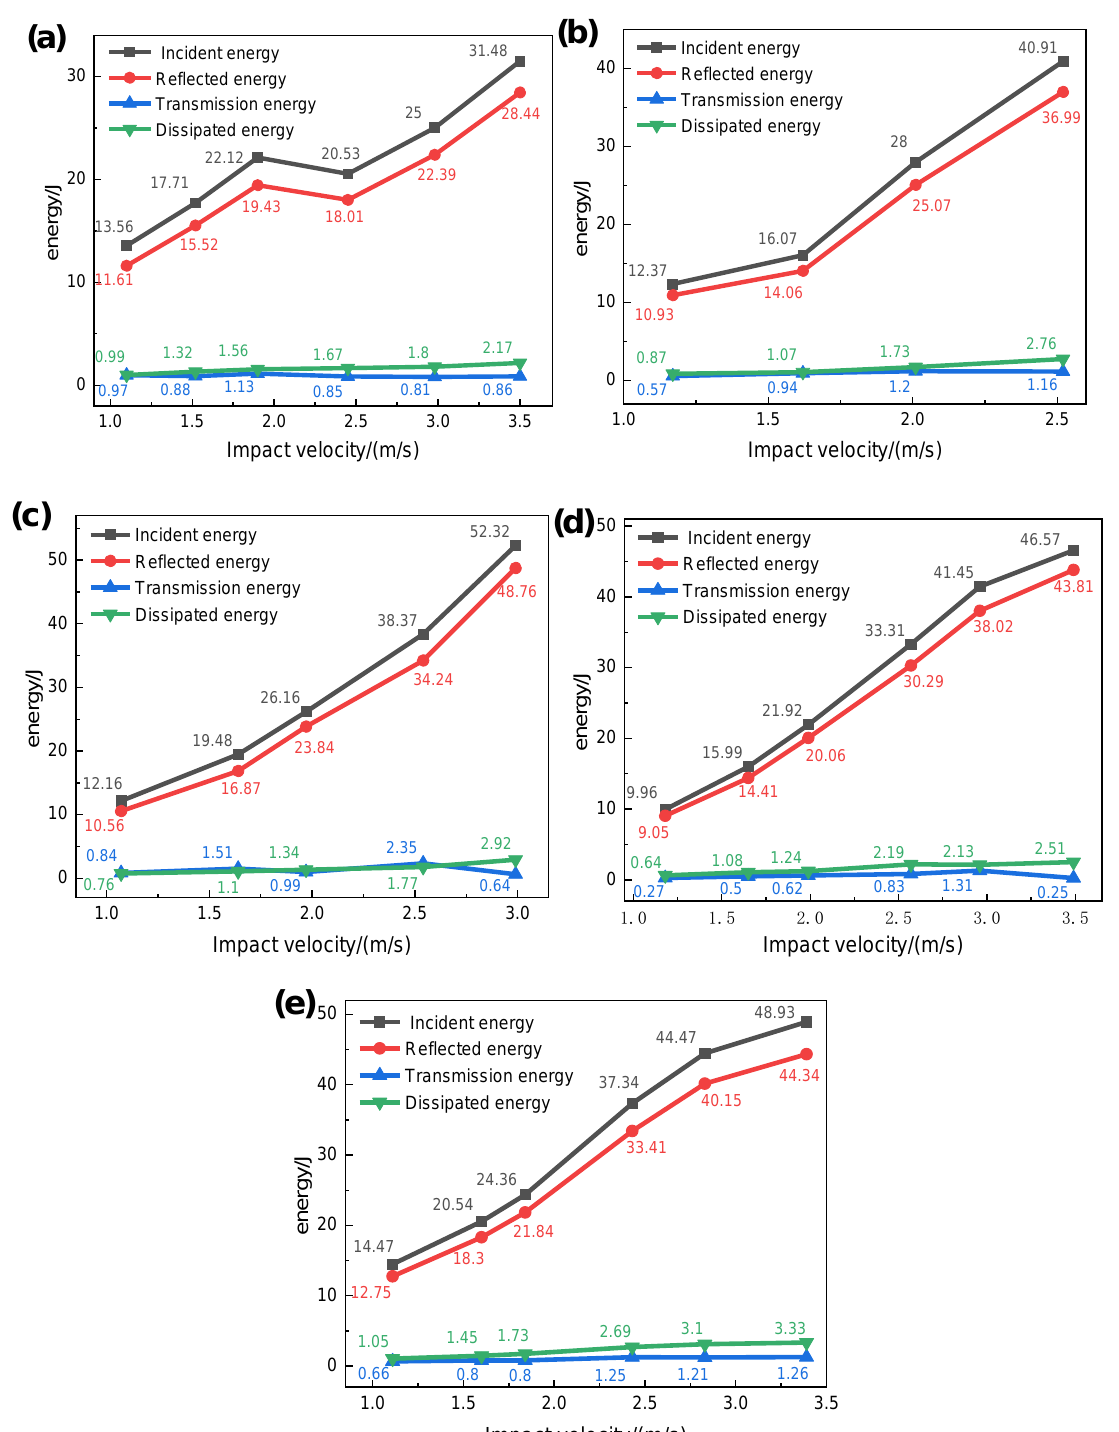
Figure 7. Incident energy, reflected energy, transmitted energy, and dissipated energy change curves with impact velocity: ( a ) 0°; ( b ) 22.5°; ( c ) 45°; ( d ) 67.5°; ( e ) 90°.